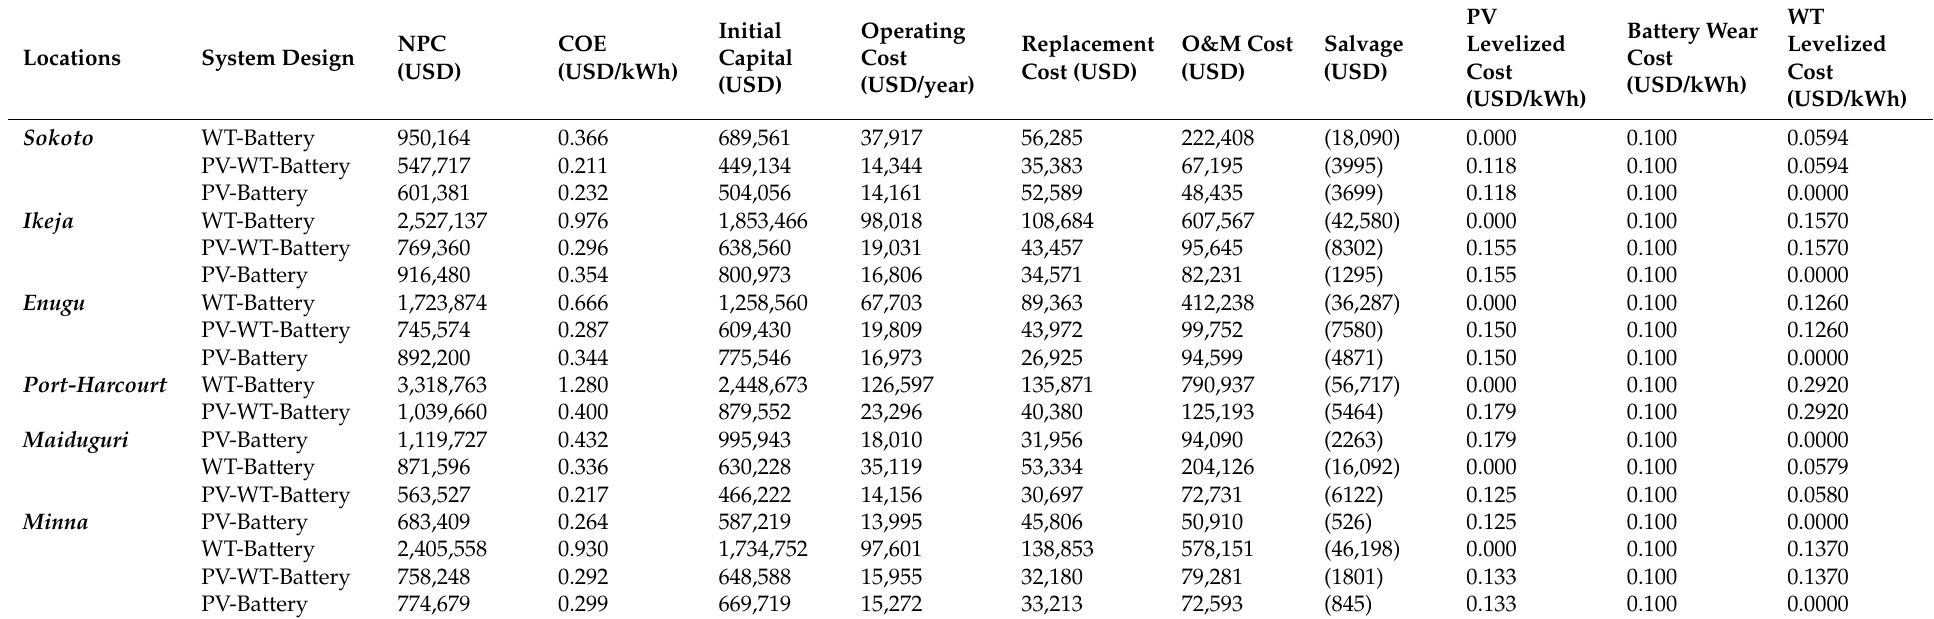
Table 13. Summarized cost details of the optimal systems for the proposed charging